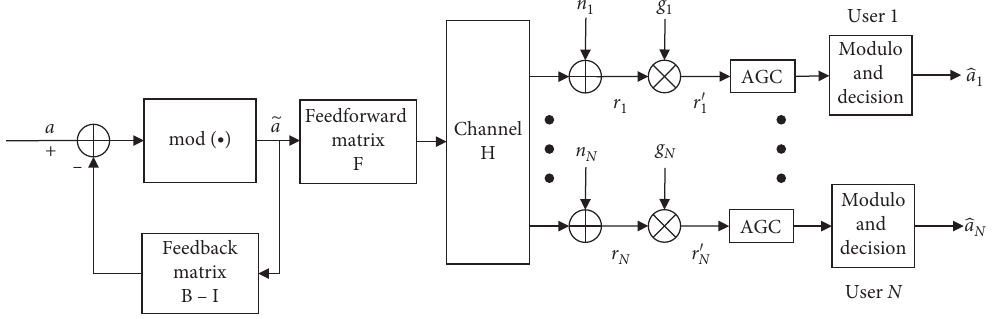
Figure 1: Multiuser THP system